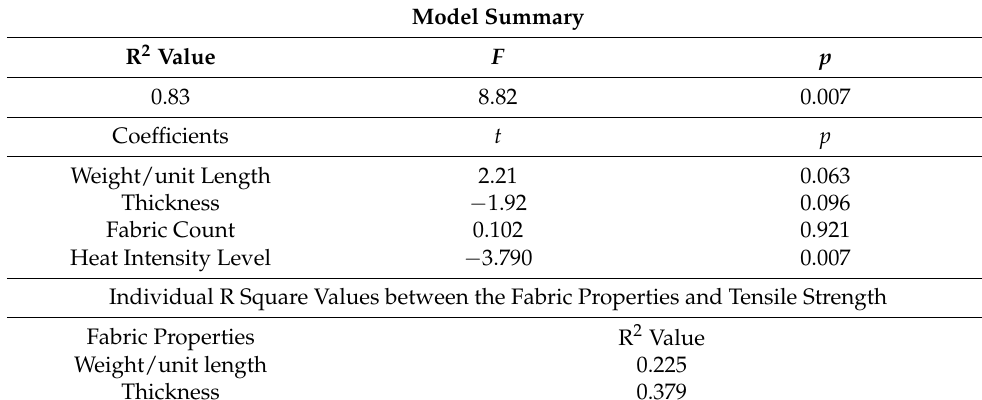
Figure 6. Effect of radiant heat on tensile strength of the fabrics in dry condition. The tensile strength of the fabric is mostly dependent on the organization of the polymer chains and the macrostructure [55–57]. A similar pattern of loss of tensile strength with increased temperature is observed from Figure 6. The loss of tensile strength can be explained due to the fibrillar to the lamellar transformations within the fibers which cause an increase in crystallinity with lamellar spacing [58]. A linear regression analysis tool has been used to find out the R square and t -test ( t and p ) values. As mentioned earlier, data have been grouped into three categories. In the first category, the tensile strength of four high-performance fabrics exposed in three different heat flux in dry conditions have been analyzed. Independent variables: (i) fabric properties (Weight/unit length, thickness, fabric count); (ii) heat flux intensities (10, 15, and 20 kW/m 2 ) are the ordinal variables. Dependent Table 4. Statistical analysis of the tensile strength of the outer layer fabrics exposed in dry